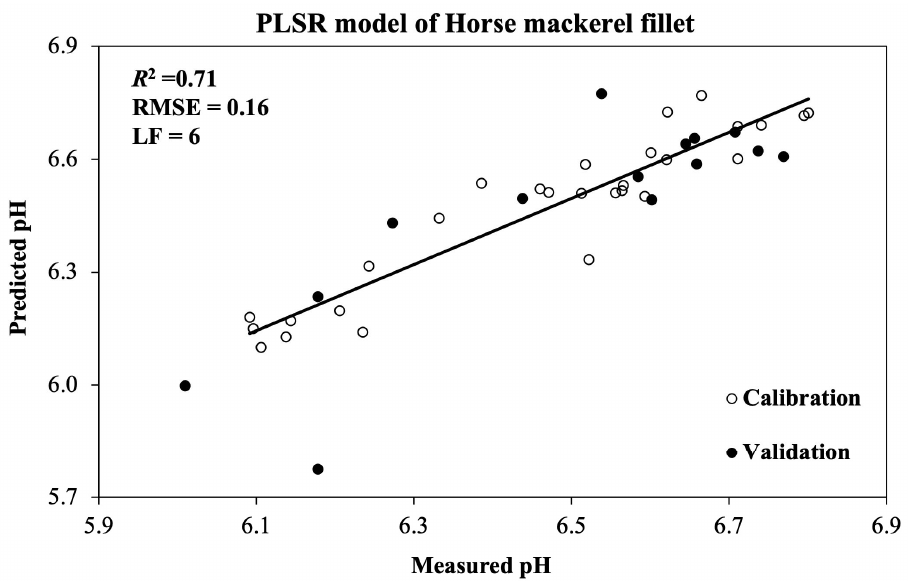
Figure 5. PLSR model for pH prediction in frozen horse mackerel fillets previously stored in ice for 0–48 h.